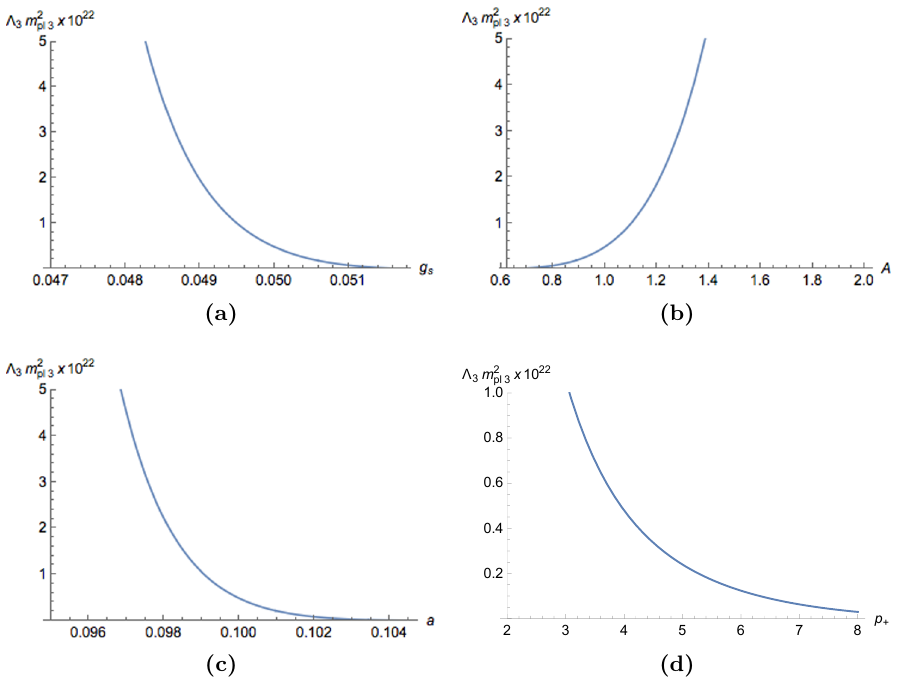
Figure 6. A plot of how the cosmological constant changes while varying parameters in the KKLT construction.